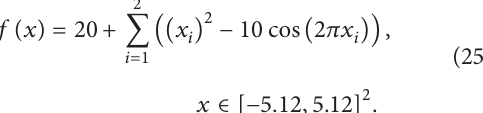
Figure 1. The global optimum of the function is 𝑥 = −5.0 with the function value 𝑓(𝑥) = −3 . There is a deceptive local minimum 𝑥 = 8.5060 with function value 𝑓(𝑥) = −2.9160 in this test